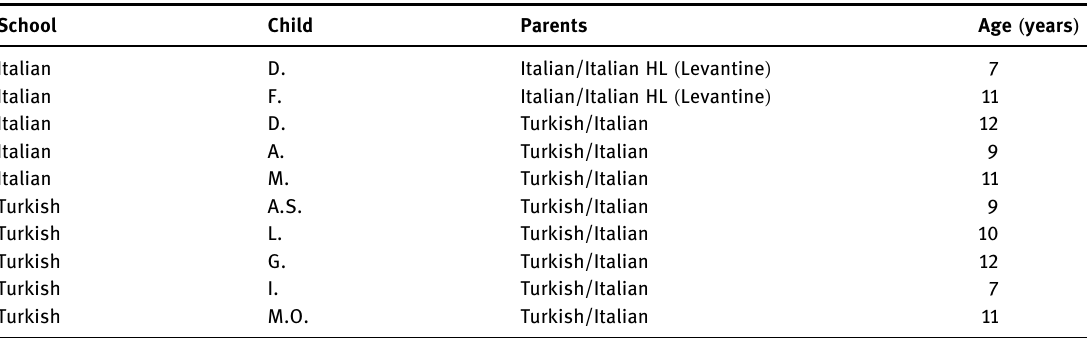
Table 1: Individual data of children involved in the study School